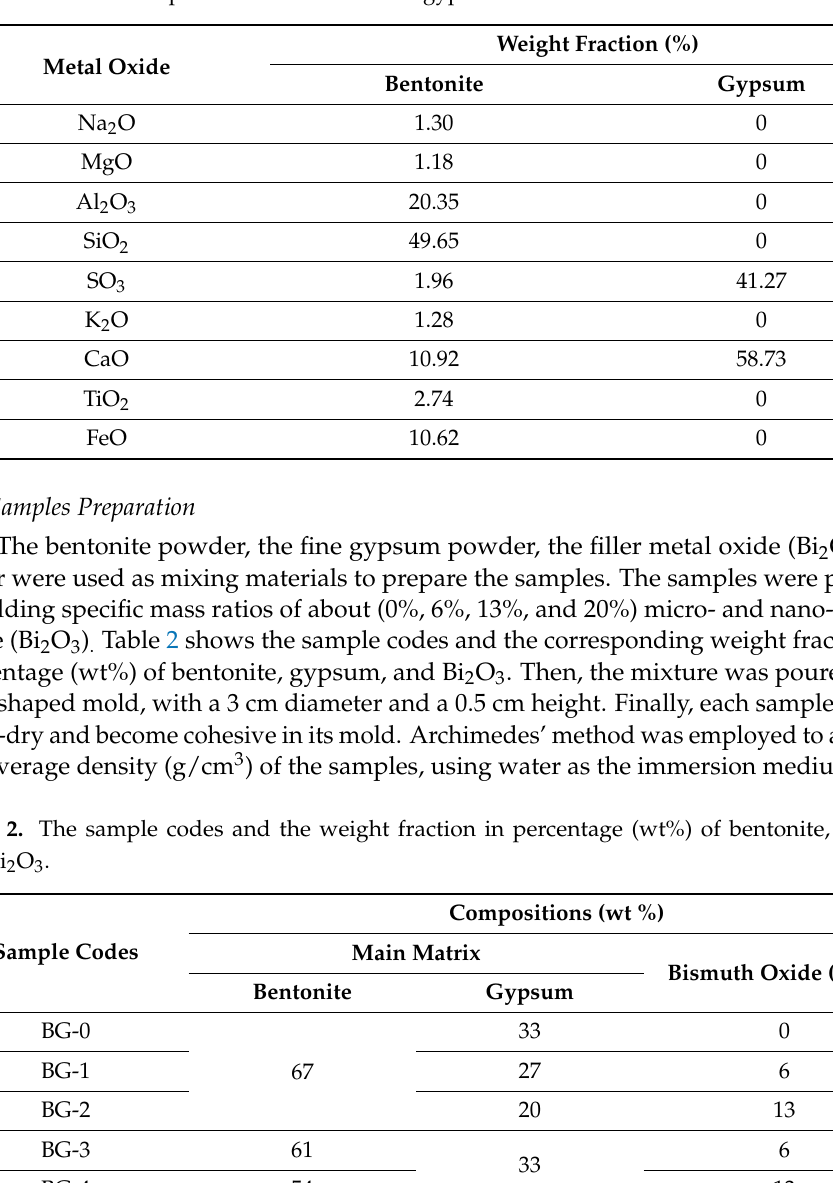
Table 1. Chemical composition of bentonite and gypsum.